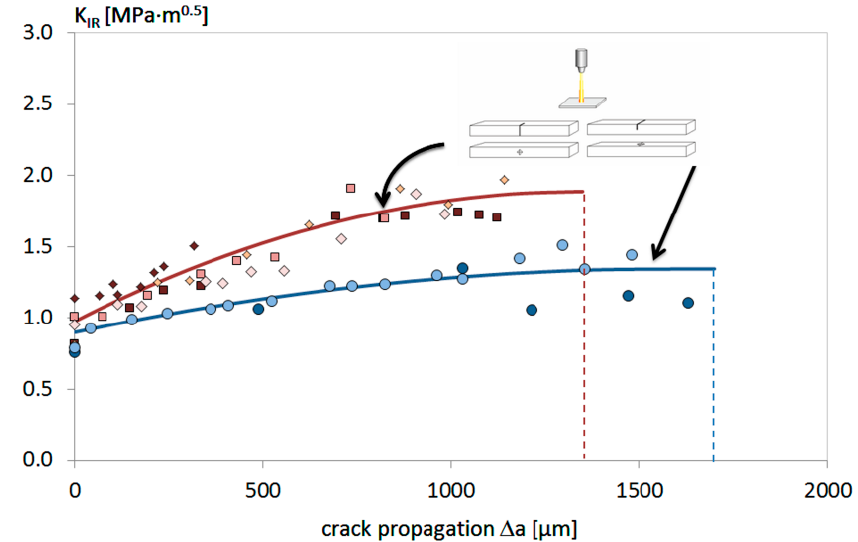
Figure 11. The R-curves for two different orientations up to the discussed limits. The blue circles indicate data from two samples with the horizontal crack growth direction, and the red diamonds and squares correspond to four samples with the vertical crack growth direction.